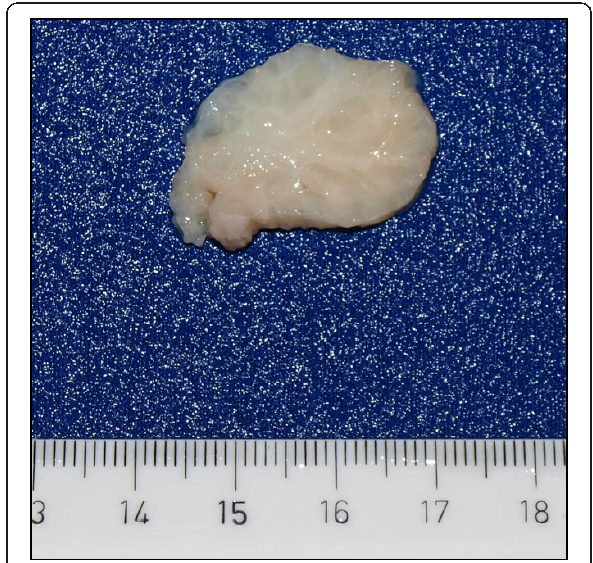
Figure 2 Appearance of cut surface of the right